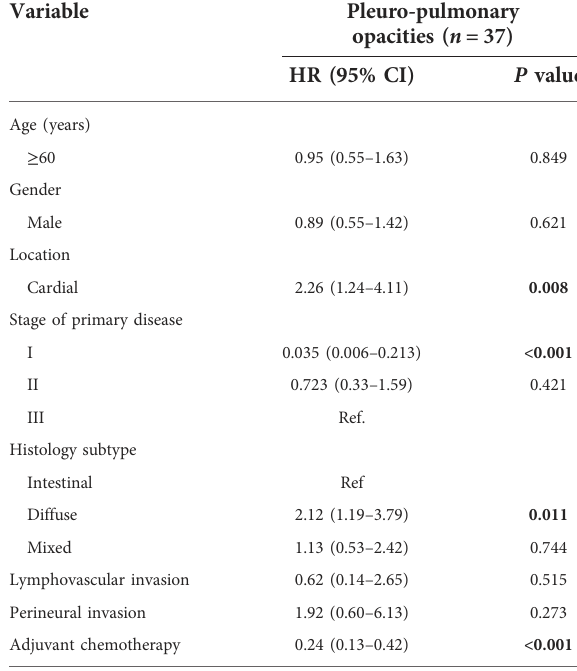
TABLE 4 Cox regression model for OS among the entire